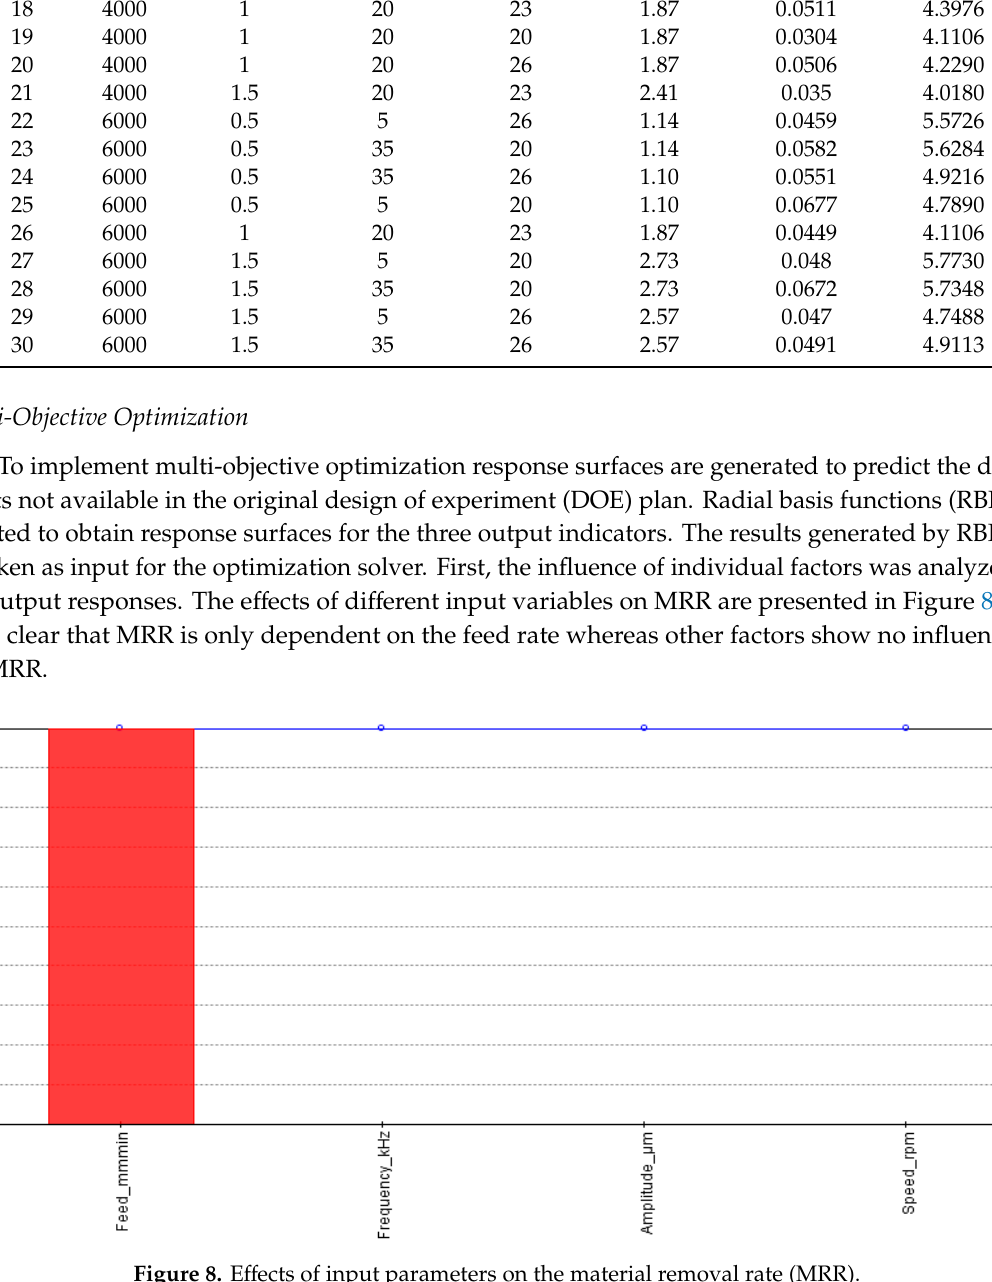
Figure 8. E ff ects of input parameters on the material removal rate Figure 8. Effects of input parameters on the material removal rate (MRR).